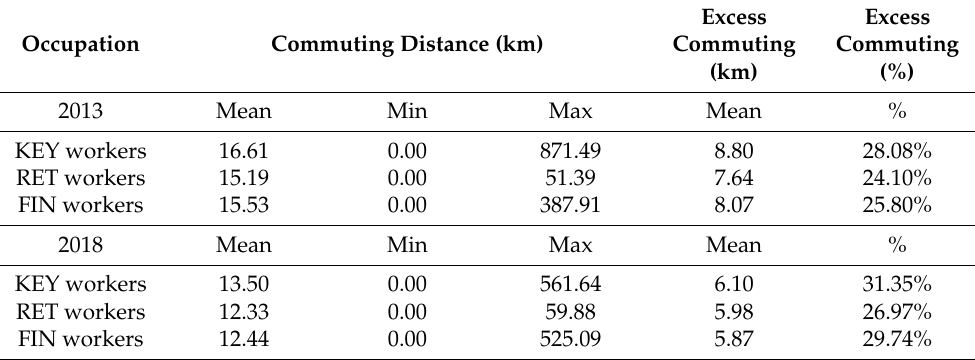
Table 3. Commuting distance pattern by occupation in 2013 and